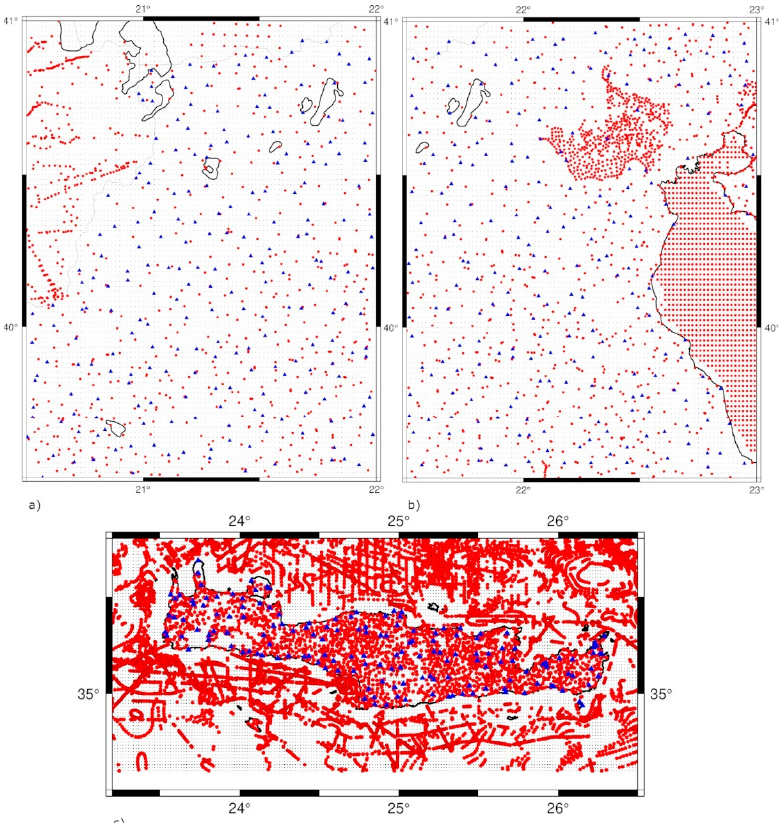
Figure 14. Distribution of available gravity and GNSS/levelling data over ( a ) Pindos, ( b ) Thessaly and ( c ) Crete. In all figures, red dots depict the available terrestrial gravity values, black dots the 1 ′ × 1 ′ GOCE-derived gravity and the blue triangles the GNSS/leveling BMs. Table 7. Statistics of the residual geoid heights ( 𝑁 (cid:3045)(cid:3032)(cid:3046) ) for the various models. Units: (m).